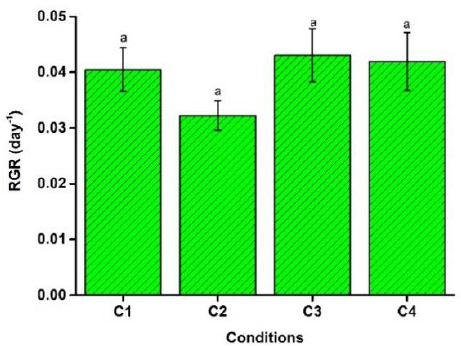
Figure 6. Effects of salinity and irradiance on relative growth rate (RGR). Values are means ± standard error, n = 6. For further information see Figure 2.